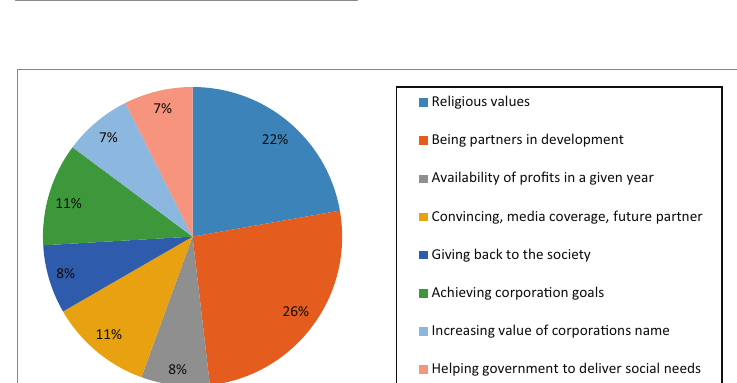
Figure 1. How is CSR perceived and for what